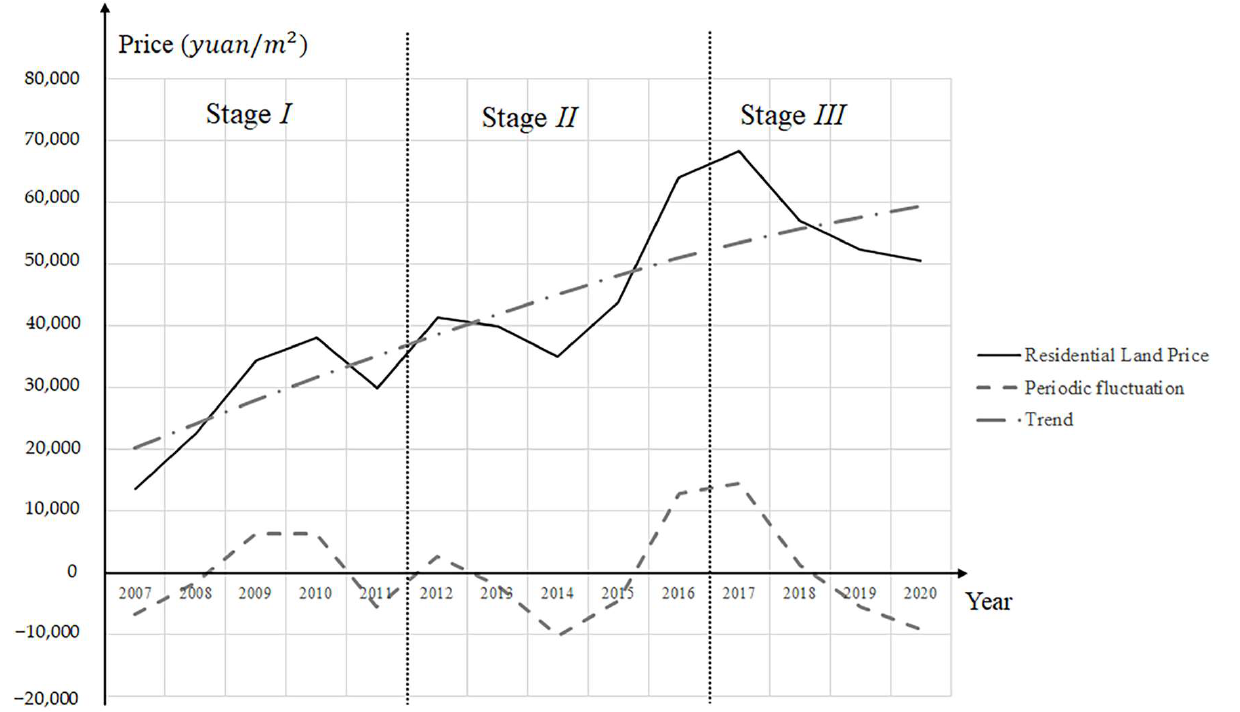
Figure 4. The HP filtering map of residential transaction land prices in Hangzhou from 2007 to 2020.